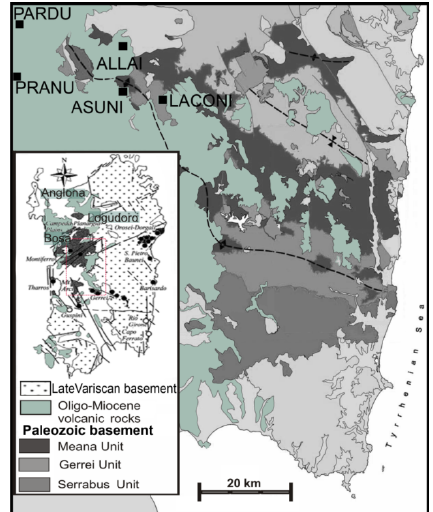
Figure 1. Simplified geological map of Central-Western Sardinia (modified by [44]), showing the outcrop area of the Oligo–Miocene volcano-sedimentary succession and the studied sites. In the area, the older Variscan basement corresponds with the Nappe Zone that consists of marine silico-clastic successions equilibrated under greenish facies. Sampled sites and labels used hereafter: P, E and I for Pranu; M and N for Asuni; H and F for